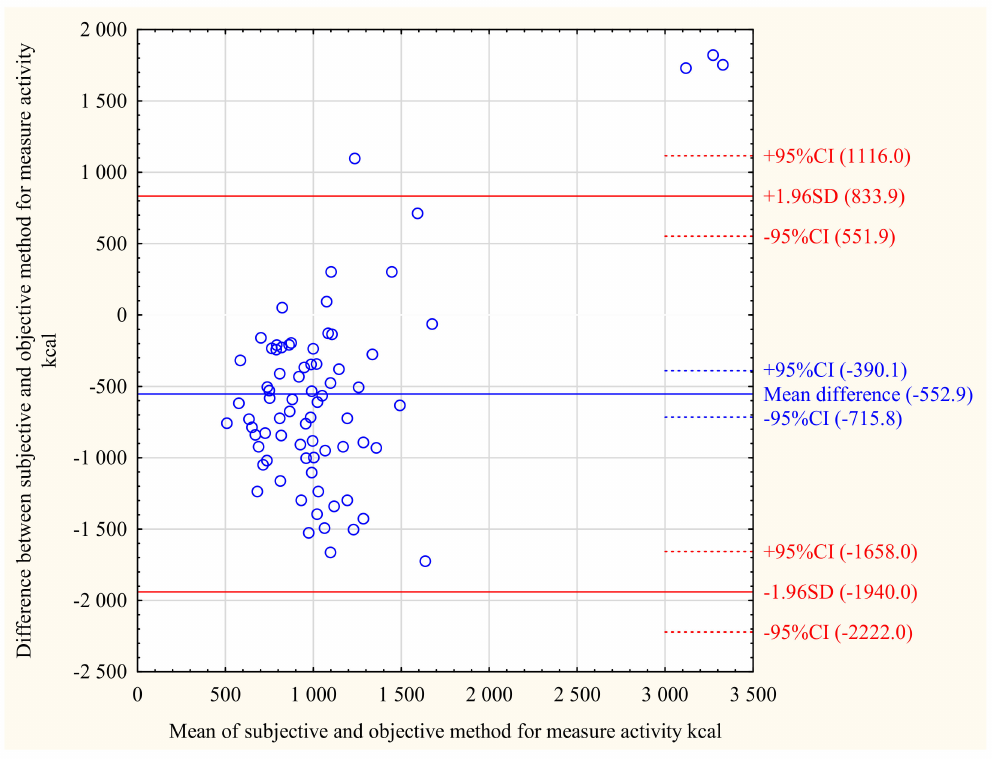
Figure 3. Bland–Altman plot for activity kilocalories per day measured by the IPAQ and ActiGraph in total study population ( n = 75). Table 5. Spearman’s rank correlation between the objective and subjective methods for measure physical activity in the study population.